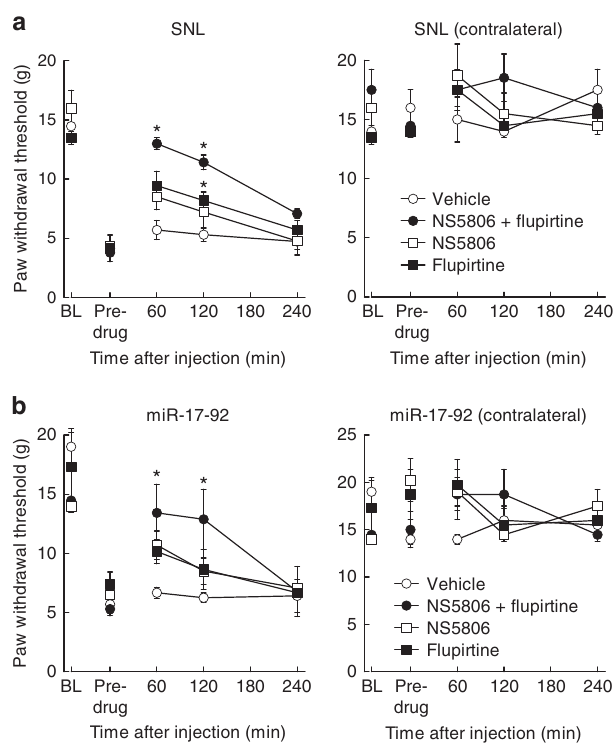
Figure 8 | Combined administration of potassium channel modulators potently alleviated mechanical allodynia induced by miR-17-92 or SNL. Paw withdrawal responses to mechanical stimuli were evaluated on the SNL ( a ) and AAV-injected ( b ) sides and the contralateral sides ( n ¼ 4). NS-5806, flupirtine or both were administered intraperitoneally 7 days after SNL; the same volume of vehicle was injected as a control. Rats were examined before SNL or AAV injection (BL), and before and after drug administration. Error bars are s.e.m. * P o 0.05 compared with vehicle, Steel